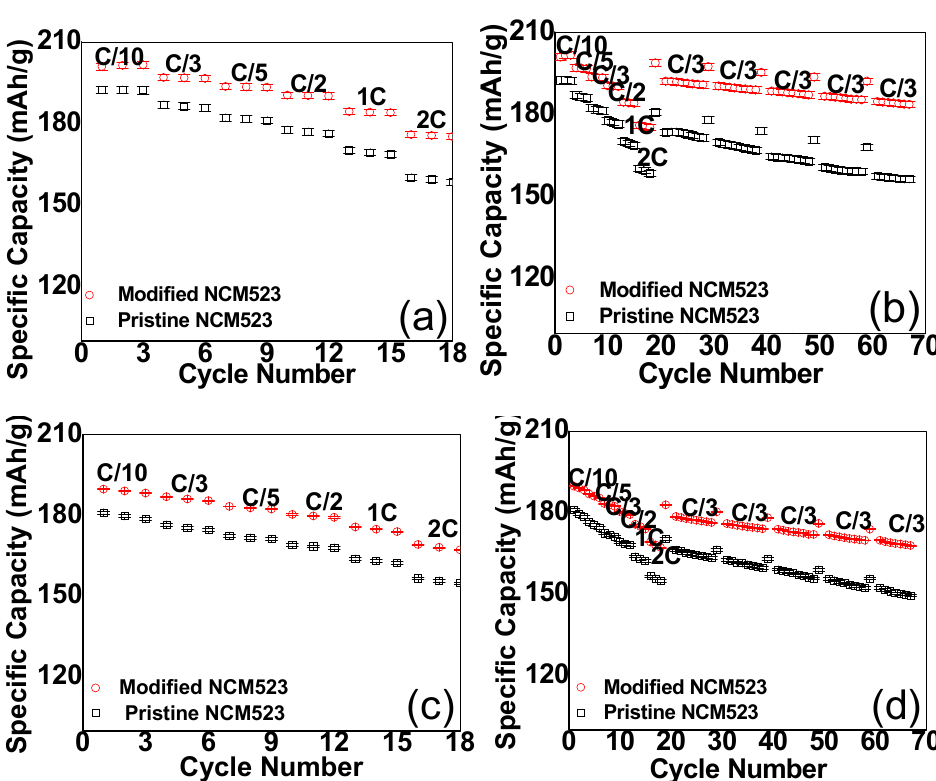
Figure 5. Rate (left) and cycling (right) tests of pristine NCM523 and NCM523 with Al 2 O 3 coating doping in ( a , b ) half-cells and ( c , d ) full cells.